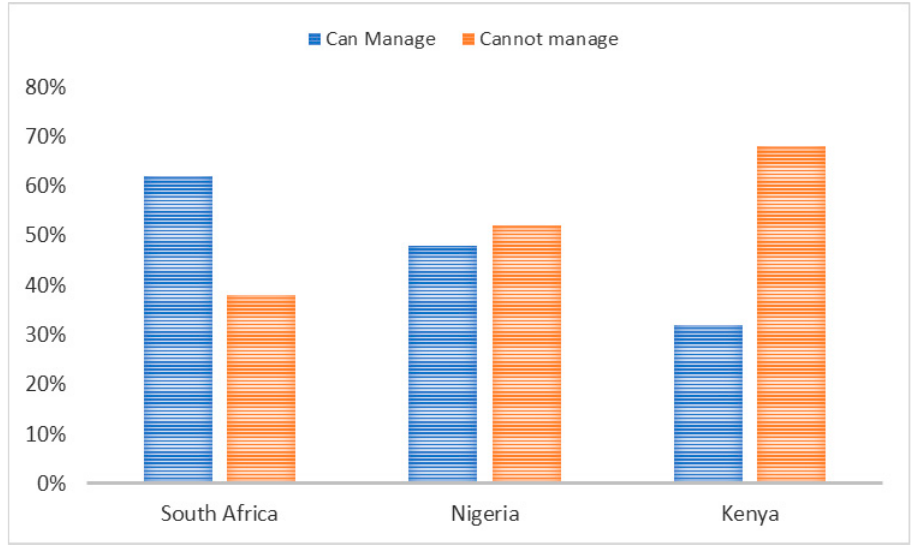
Figure 8. Ability to manage household hazardous waste (HHW). Source: [42].